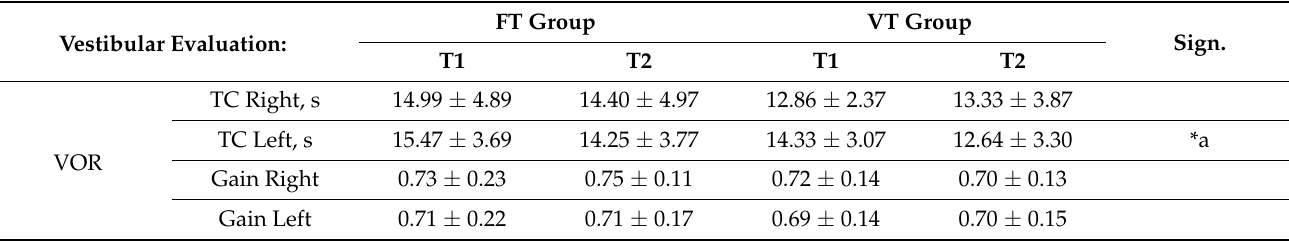
Table 2. Values of the VOR evaluation parameters for Face-to-Face Training Group and Videoconference Training Group before (T1) and after (T2) the training period. TC—time constant of the ocular reflex, gain—the relation of the maximal ocular velocity to the rotatory velocity of the head, both parameters calculated for the Left and Right semicircular canals. Sign.—Significance level, * p ≤ 0.05; a: intervention effect (corresponds to a significant effect of intervention for both groups).